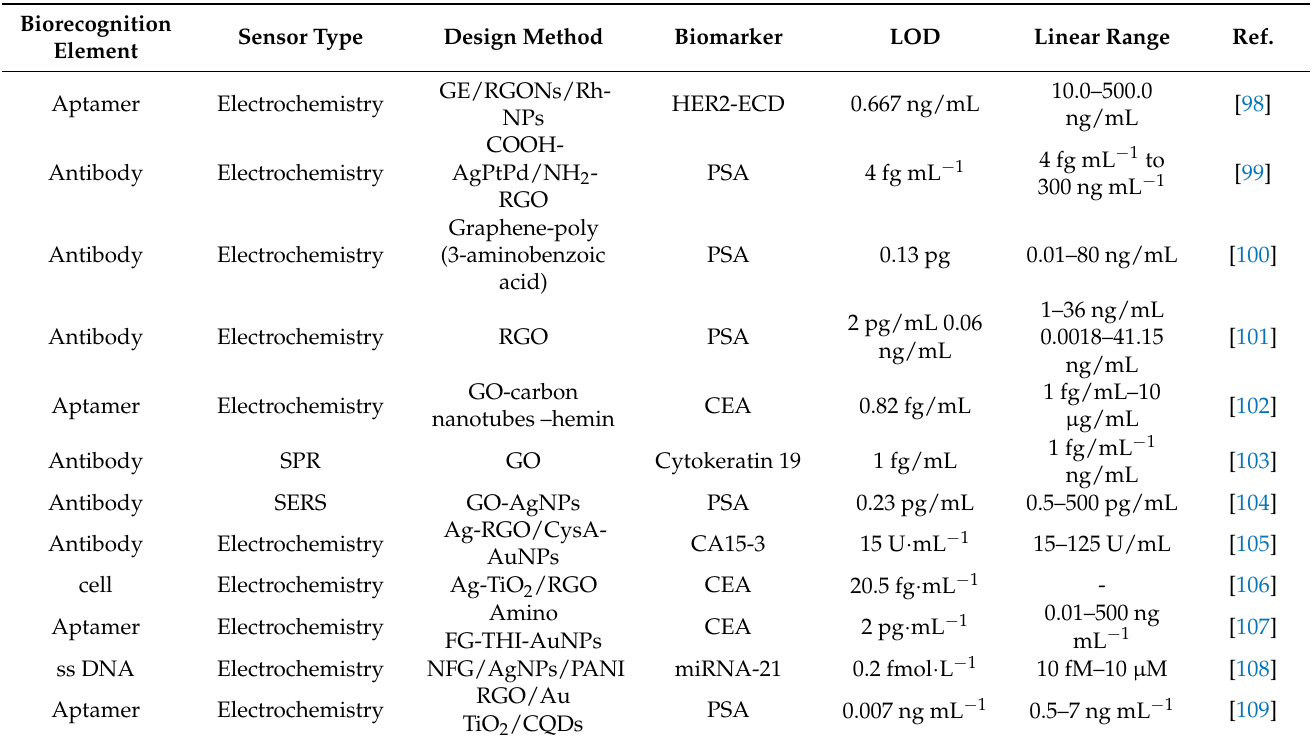
Table 1. Types of biorecognition elements used in graphene-based biosensors for the detection of various cancer